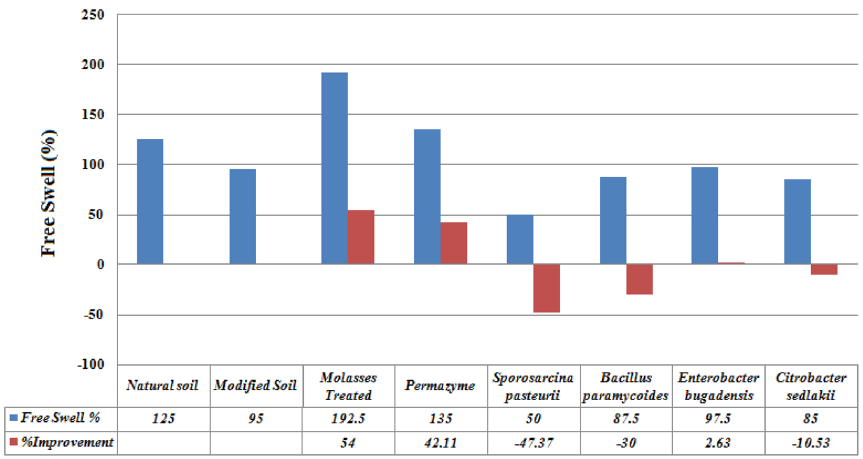
Fig.4 Free swell index the natural, modified, molasses and bioenzyme treated and 7 days cured soil